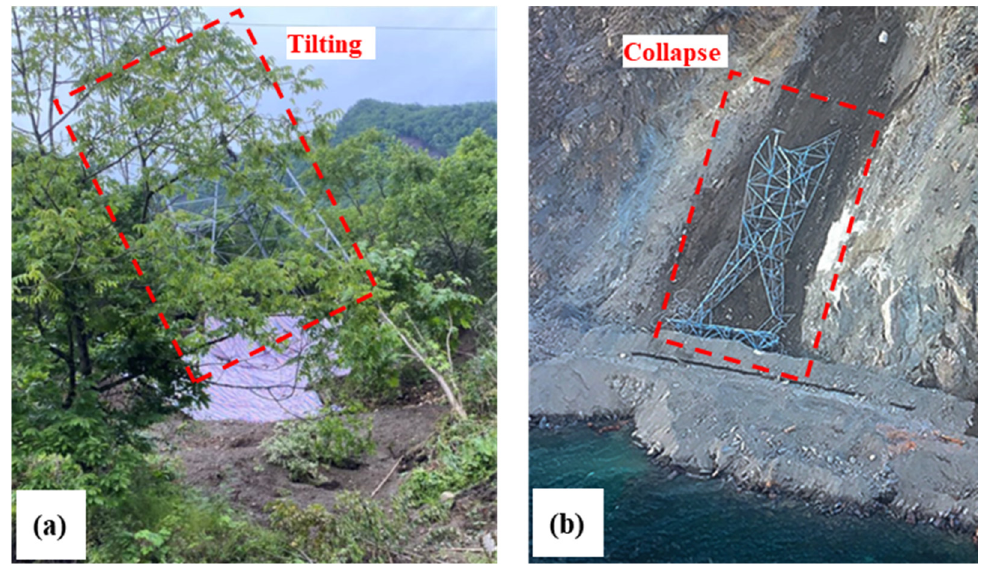
Figure 1. The grid accidents induced by landslides: ( a ) tilting; ( b ) collapse.